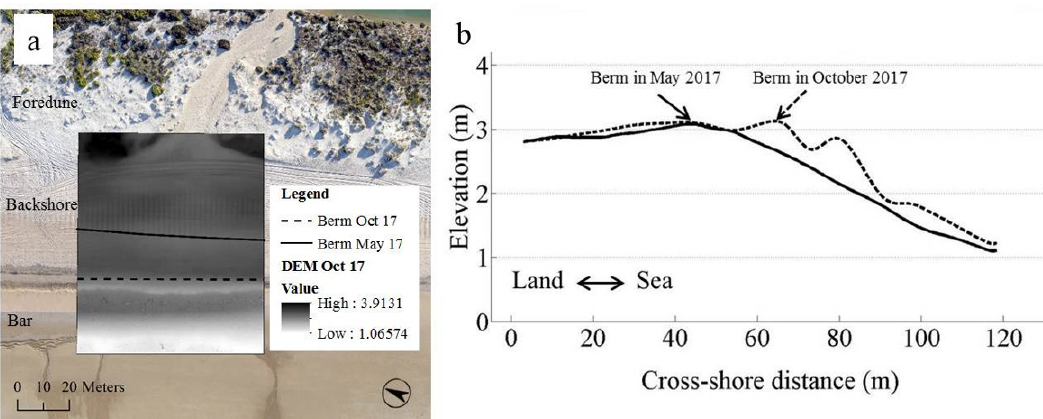
Figure 7. ( a ) DEM from October 2017 in the area close to P1, displaying the berm from May 2017 (solid line) and October 2017 (dashed line); ( b ) cross-shore profiles of the study site (close to P1) displaying the berms in May 2017 (solid line) and October 2017 (dashed line).